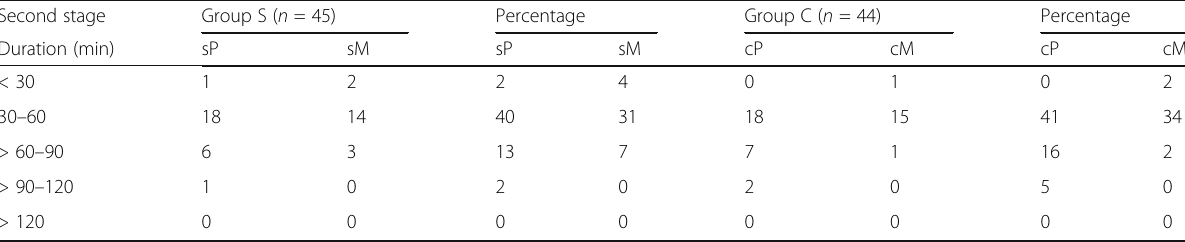
Table 2 Comparison of duration of second stage of labor Second stage